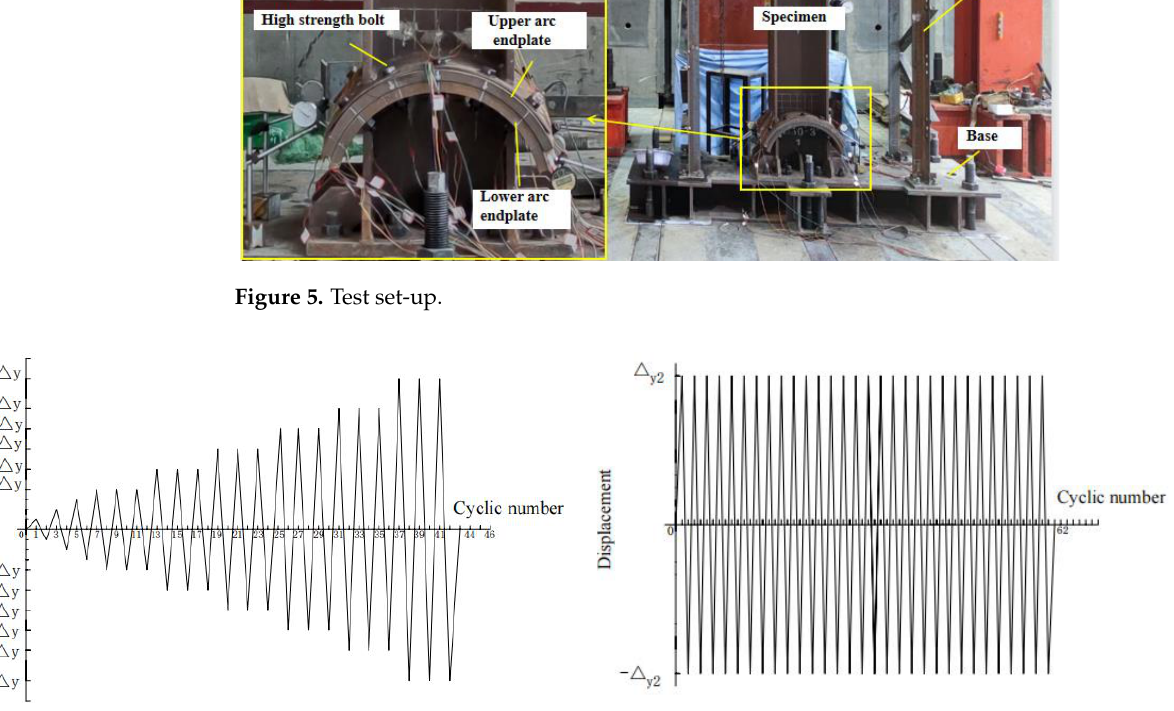
Figure 6. Horizontal loading protocol: ( a ) Variable amplitude constant-amplitude loading protocol; ( b ) Constant-amplitude loading protocol.